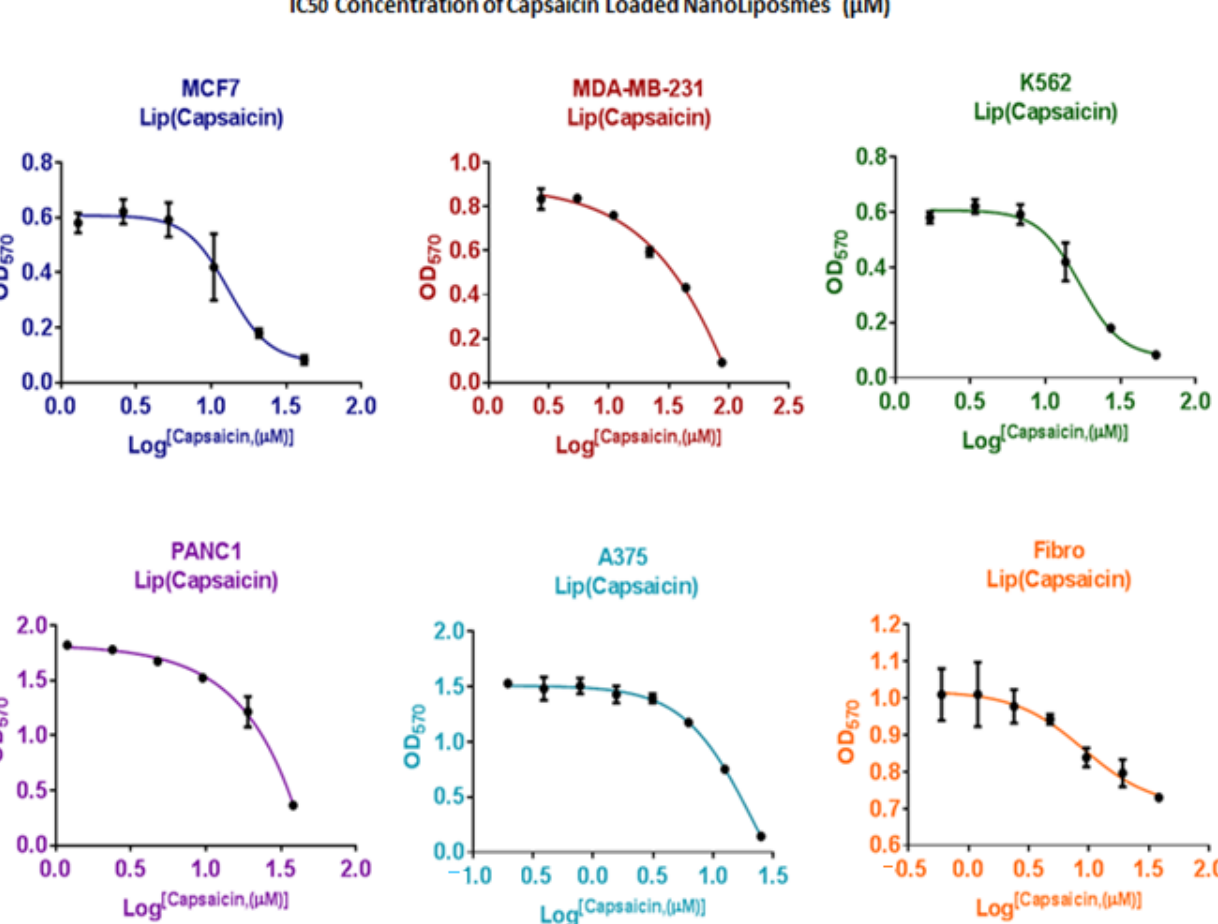
Figure 7. Cytotoxicity and the half maximal inhibitory concentration (IC 50 ) of CAP-loaded nanoliposomes against human fibroblasts normal cells as negative control and human cancer cell lines (MCF7, MDA-MB-231, A375, K562 and PANC-1).